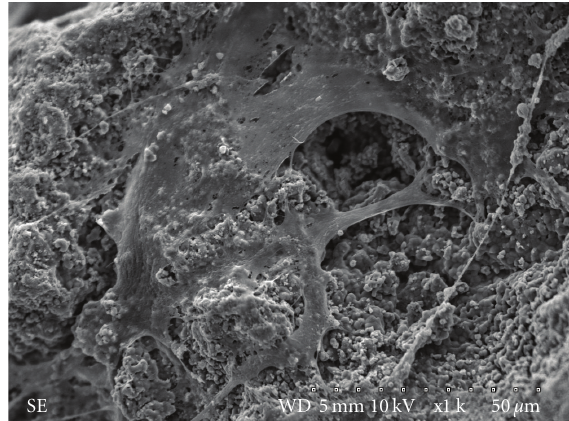
Figure 4: Human mesenchymal stem cells on the surface of a granule (40–60 mesh). SEM image shows stem cells spreading on the BCP surface and forming layers over the apertures of porous, after 7 days of culture.